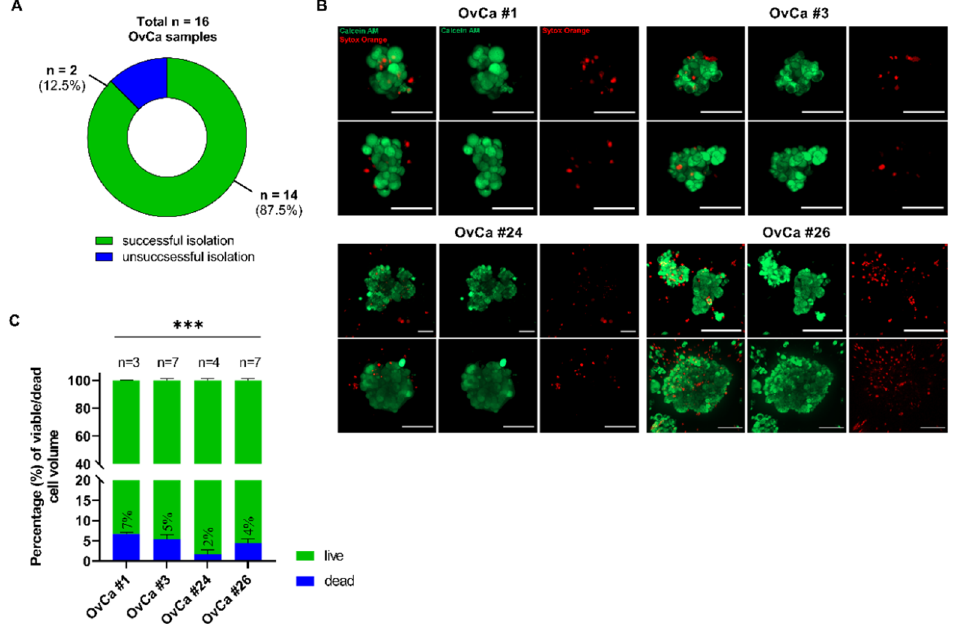
Figure 1. Patient-derived 3D microtumors (PDM) derived from primary OvCa tumor specimen show high viability. ( A ) Efficiency of isolating OvCa PDM from a total of n = 16 fresh primary OvCa tumor tissues samples. PDM were successfully isolated from n = 14 specimen with a success rate of 87.5%. ( B ) Viability of OvCa PDM models. Exemplary 2D images from 3D projections of n = 4 OvCa PDM models confirm high viability according to Calcein-AM (viable cells) and SYTOX™ Orange (dead cells) staining. ( C ) Percentage of viable and dead cells in OvCa PDM. Viability was assessed by an image-based analysis (see SI Methods) in n = 4 OvCa PDM models shown in ( B ). Data are shown as mean values with SEM from at least n = 3 PDM of each model. *** p < 0.001, multiple paired t -test with Holm-Šídák’s post hoc test. Scale bar 50 μ m.